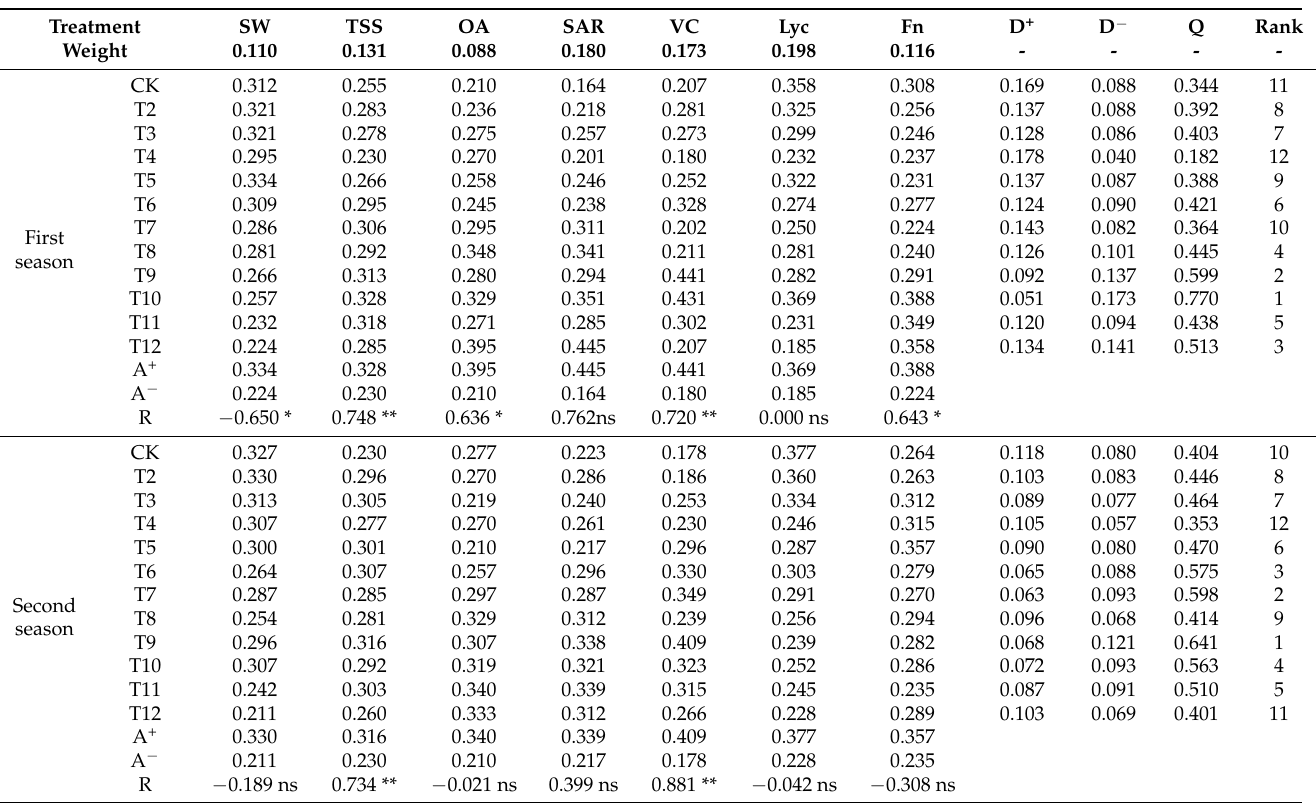
Table 4. TOPSIS analysis of comprehensive fruit quality under different water and nitrogen treatments in the first and second seasons of